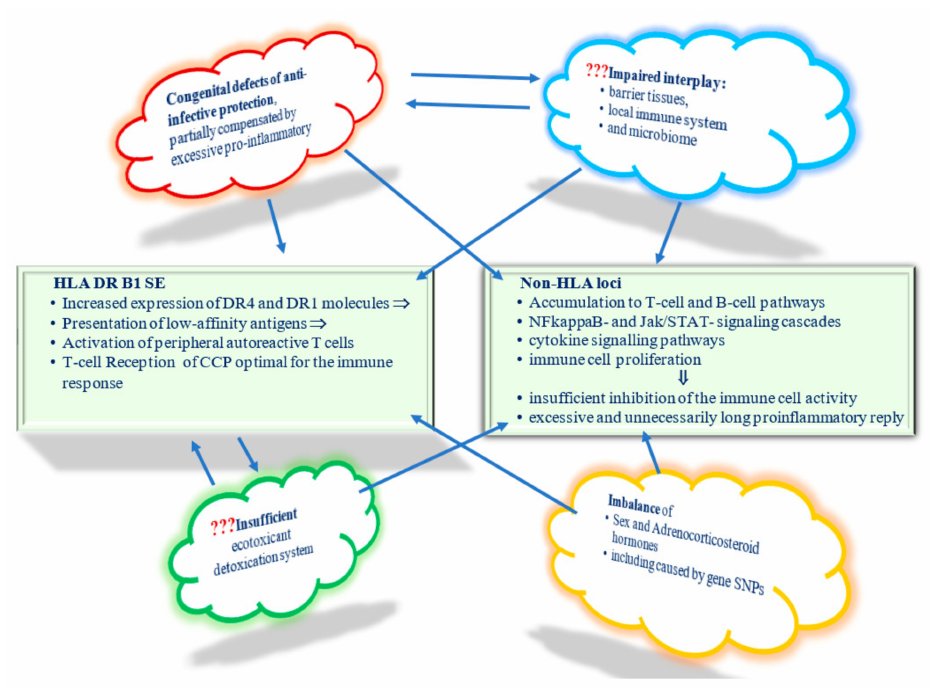
Figure 4. Mosaic of weak links of the body at RA